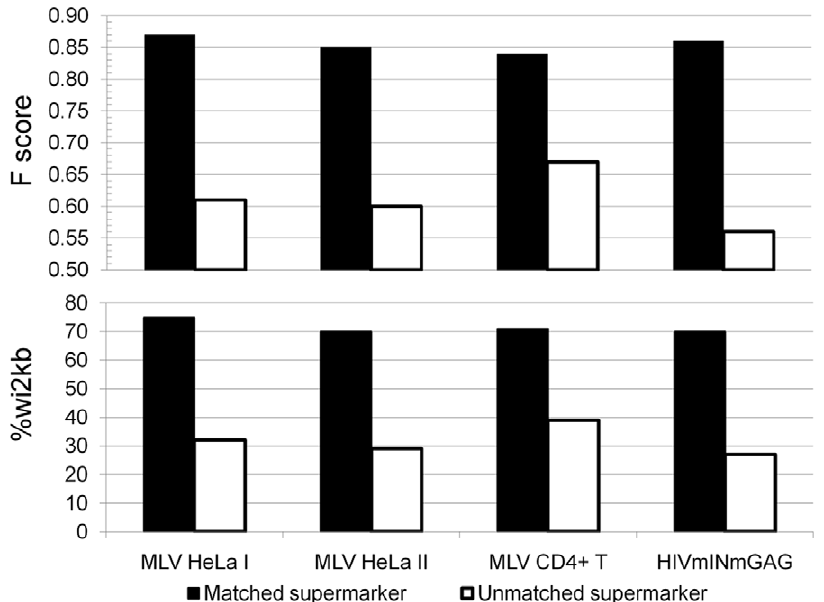
Figure 10. Influence of dataset matching on the F score. Histograms of the F score (upper panel) and the percentage of associated proviruses wi2kb of the supermarkers (lower panel) with respect to MLV proviruses, either from Lewinski et al (MLV HeLa I) or Wu et al (MLV HeLa II), and the HIVmINmGAG chimera, as indicated. Supermarkers were generated with ChiPSeq data from HeLa cells or from CD4 + T cells and compared with MLV proviruses from either HeLa cells or CD4 + T cells. ‘‘Matched’’ means that the provirus and the supermarker are from the same cell type.